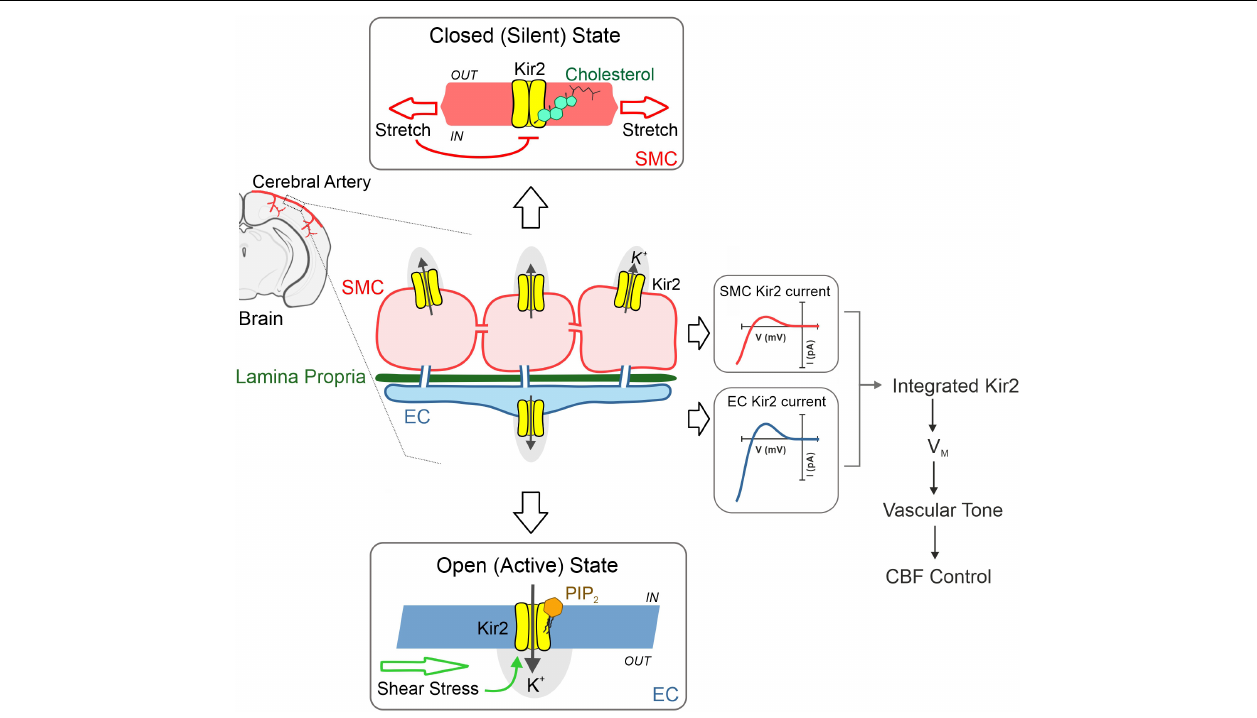
FIGURE 4 | Cerebrovascular Kir2 channels and hemodynamic control. Schematic depiction explaining the modulation of two cellular populations of Kir2 channels, functionally expressed in smooth muscle and endothelium. Briefly, structural membrane lipids including PIP 2 , and cholesterol represent primary regulators of Kir2 channels, with the former robustly stimulating endothelial Kir2, whereas the latter preferentially suppresses smooth muscle Kir2 activity. These lipid-Kir interactions help confer pressure and shear stress sensing, hemodynamic forces that diminish and enhance smooth muscle and endothelial Kir2 channel activity, respectively. These cellular channel populations dynamically interact to drive an integrated Kir2 current through which hemodynamic stimuli contribute to set V M , arterial tone and cerebral blood flow (CFB) control. Modified from Sancho et al. (22).